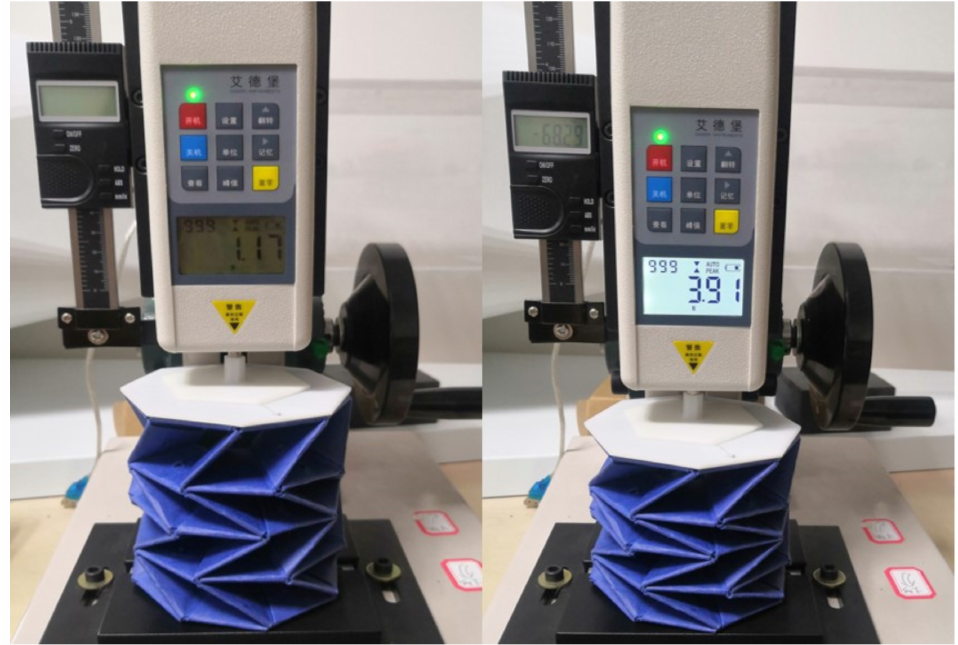
Figure 8. Experimental setup for testing the mechanical properties of twisted